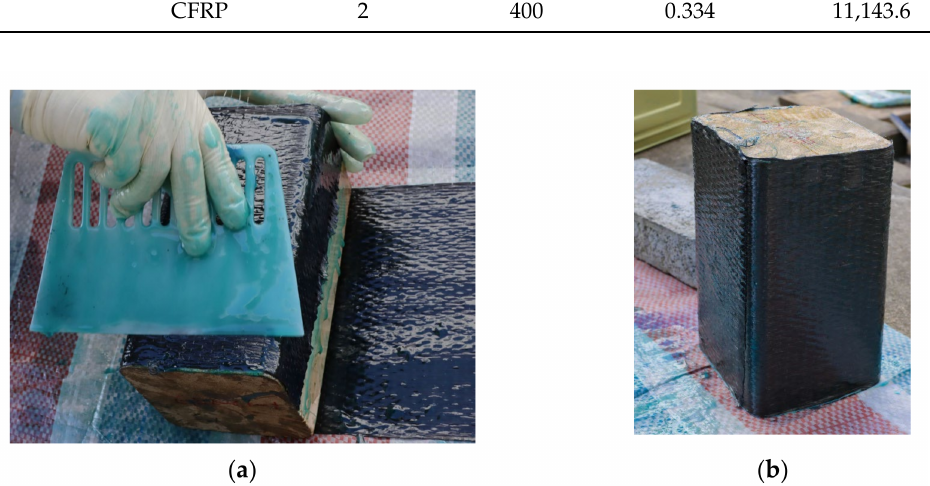
Figure 2. Specimen preparation: ( a ) wrapping the specimen with FRP sheets; ( b ) completed